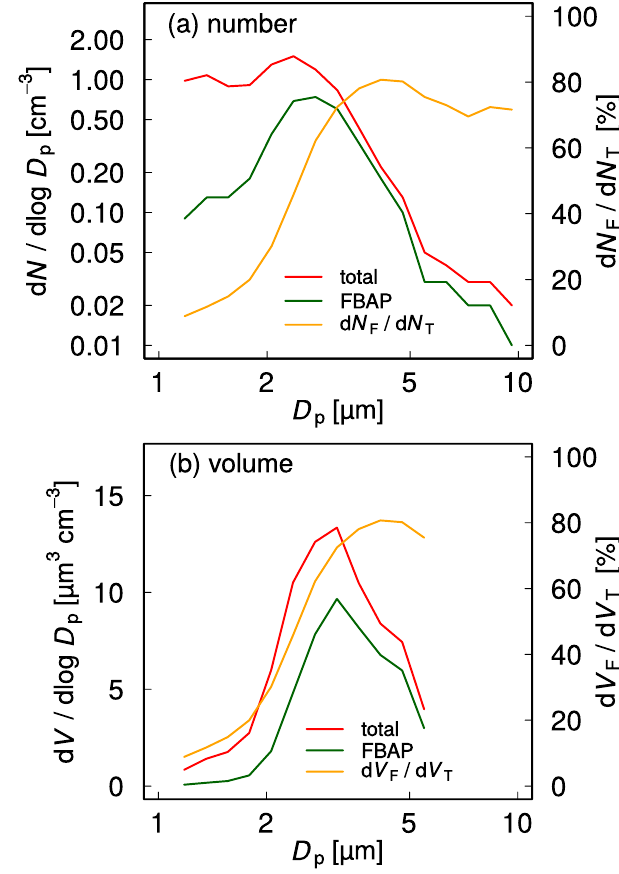
Figure 28. Median particle number (a) and volume (b) size dis- tributions from the SMPS and OPS instruments, showing the contrast between pristine wet season conditions and episodes with long-range transport influence (i.e., Saharan dust, African biomass burning, and sea salt). Wet season number and volume size spectra are taken from Fig. 27. The long-range transport size spectrum is averaged from three selected episodes in Feb and Mar 2014. Integrated number and volume concentrations for the long-range transport episodes: N Ait,long = 80cm − 3 , N Acc,long = 308cm − 3 , N Total,long = 409cm − 3 ; V sub − µ, long = 2.3µm 3 cm − 3 ,